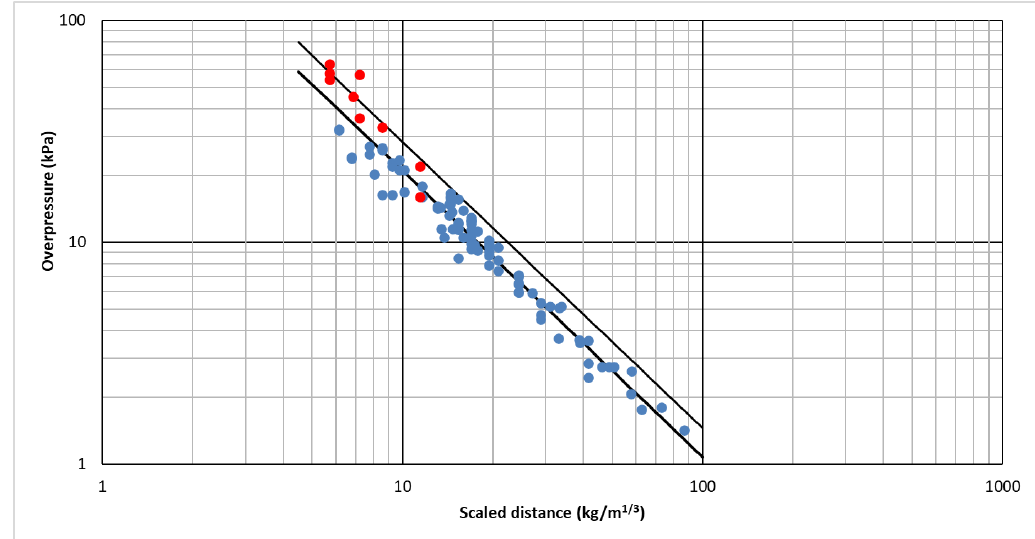
Figure 8. Overpressure measured as a function of scaled distance for the detonation of pure TNT and equivalent TNT (dots are actual values while lower and upper lines correspond to Equation 8 and Equation 9 respectively).